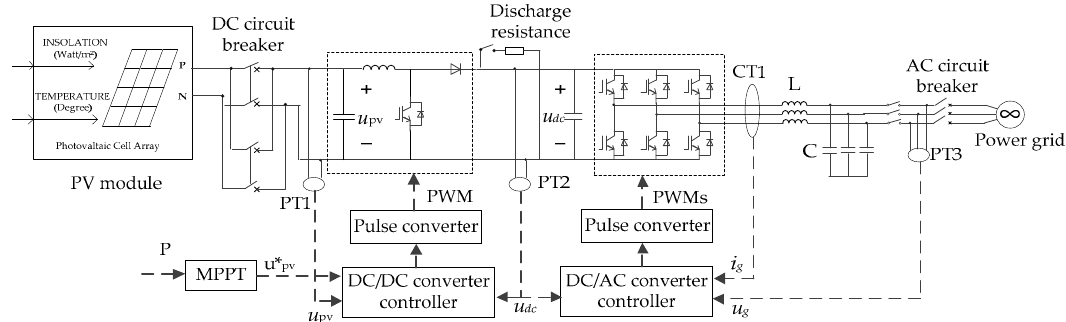
Figure 16. Internal structure diagram of Huawei SUN2000 PV inverter.